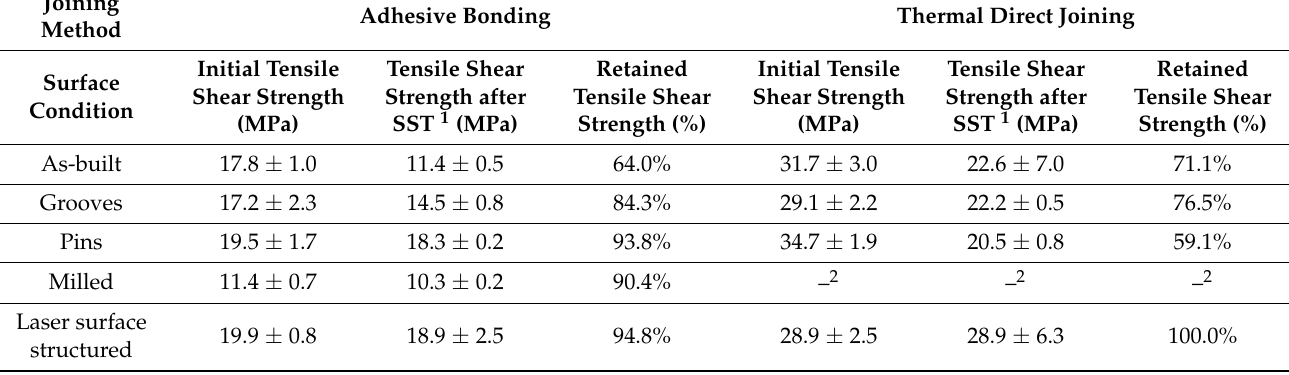
Table 2. Overview of initial tensile shear strength and retained tensile shear strength after salt spray testing for adhesive bonded and thermally direct joined specimens .